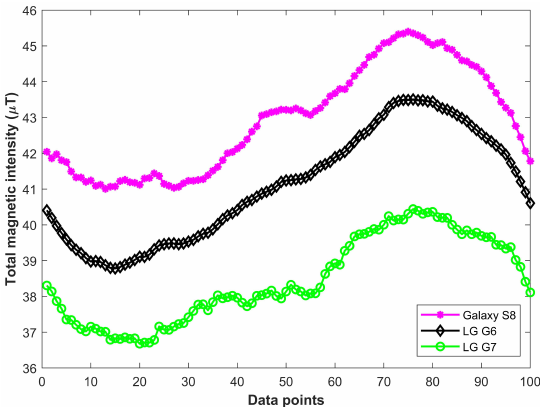
Figure 4. Impact of various smartphones on magnetic data.